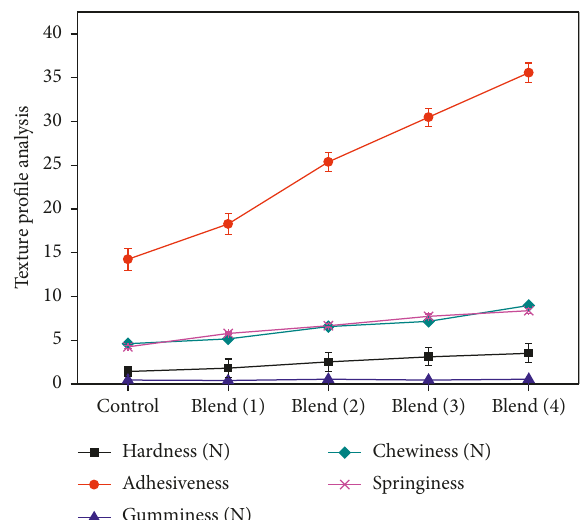
Figure 5: Texture profile analysis of pan bread